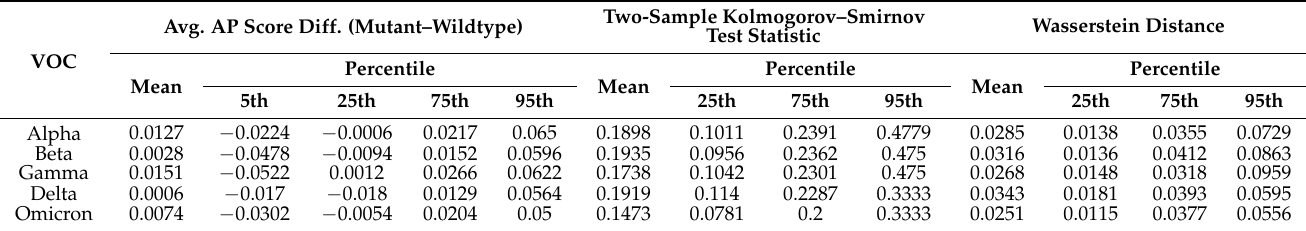
Table 3. Mean, 5th (for the average AP score difference only), 25th 75th, and 95th percentiles of the Wasserstein distance, of the two-sided Kolmogorov–Smirnov statistic, and of the average difference in AP score between mutant and wildtype epitopes across the HLA alleles for each